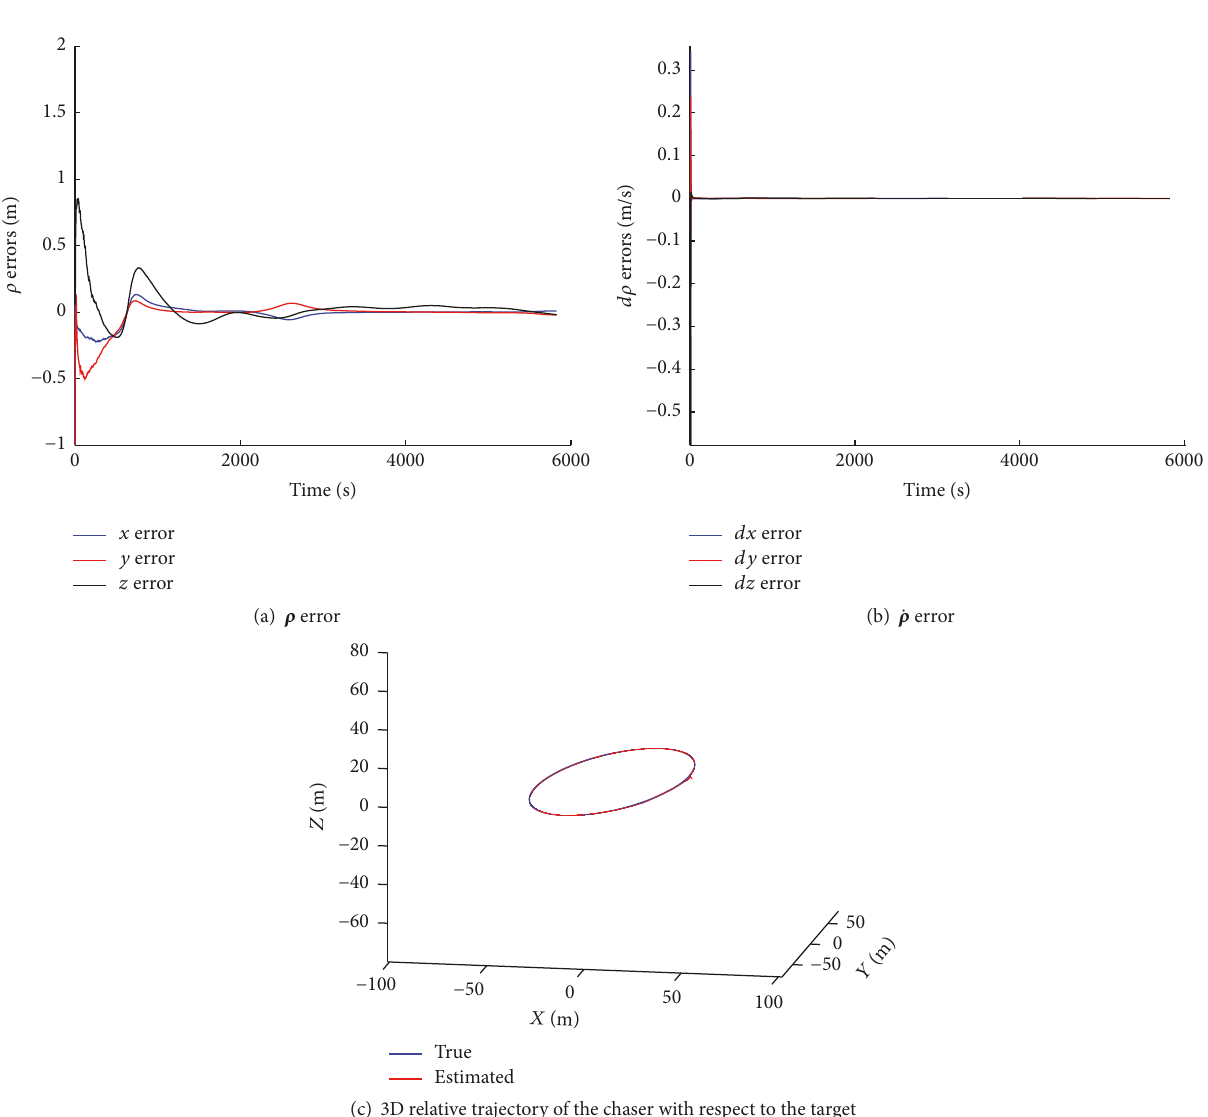
Figure 9: (a) Relative position error in components: 𝜌 − ̂ 𝜌 (m). (b) Relative position velocity in components: ̇ 𝜌 − estimated 3D relative